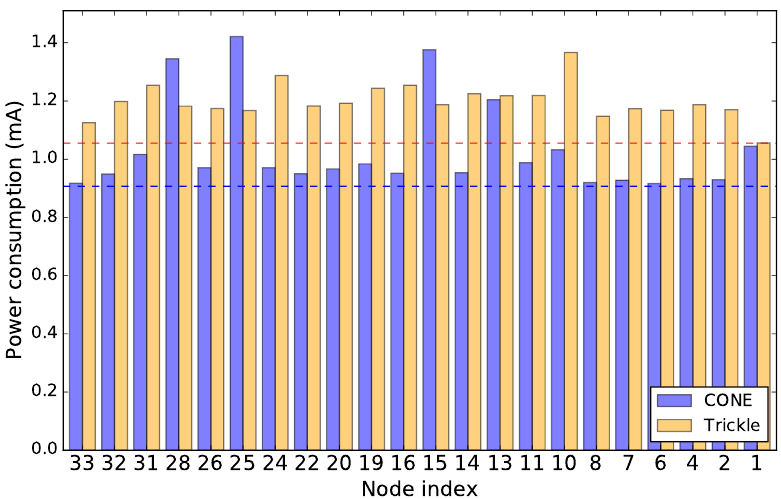
Figure 17. Comparison of energy consumption between CONE and the baseline protocol Trickle in FlockLab experiments. The dashed blue line shows the average energy consumption of all nodes in CONE while the dashed red line indicates the corresponding value in